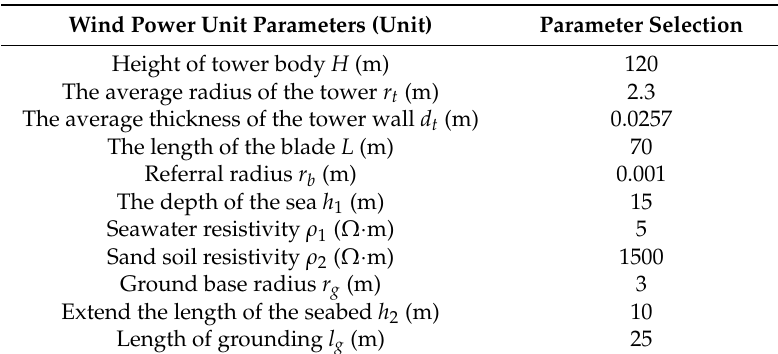
Table 1. Standard model parameters in simulation.